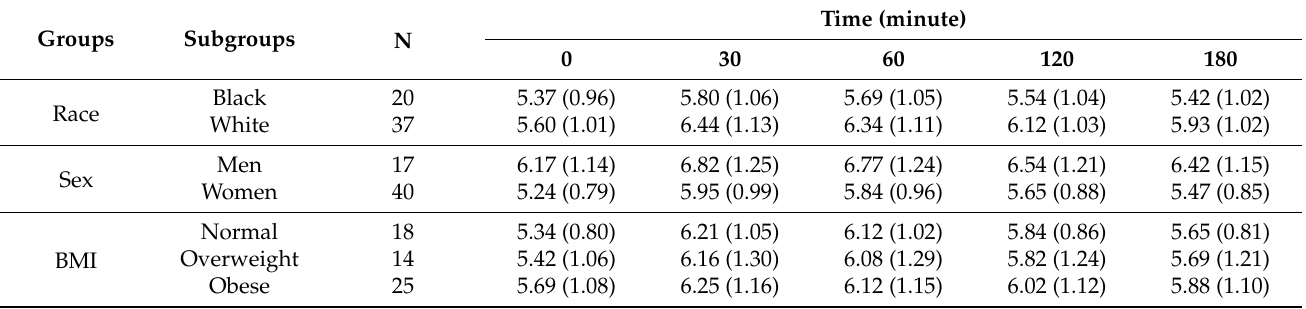
Table 2. Serum urate (mg/dL) at five time points, by race, sex, and BMI